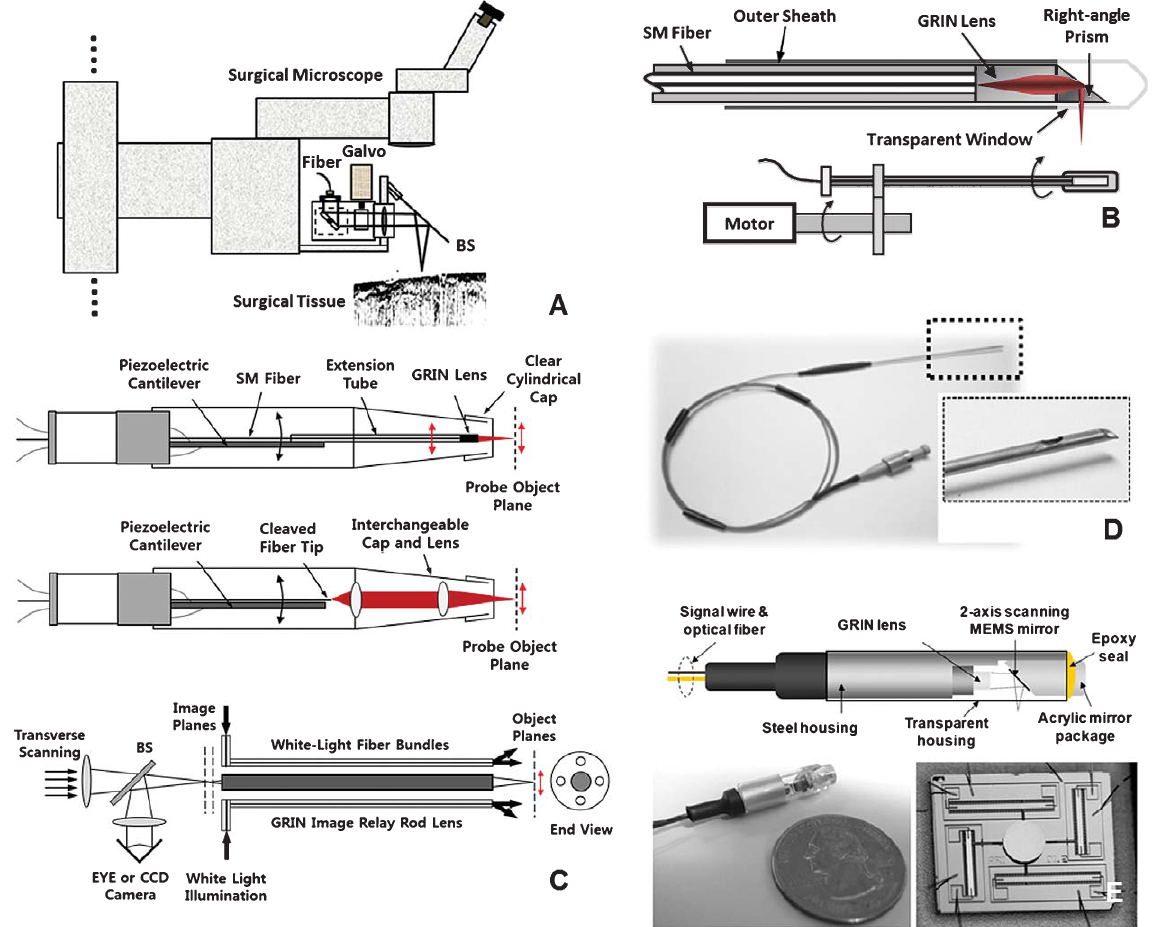
Fig. 2. Beam delivery instruments. Various OCT imaging probe can be implemented which include (A) surgical and research microscope, (B) fiber-optic catheter, (C) hand-held probes and laparoscope, (D) optical needle-probe, (E) 2-D MEMS scanner based endoscopic